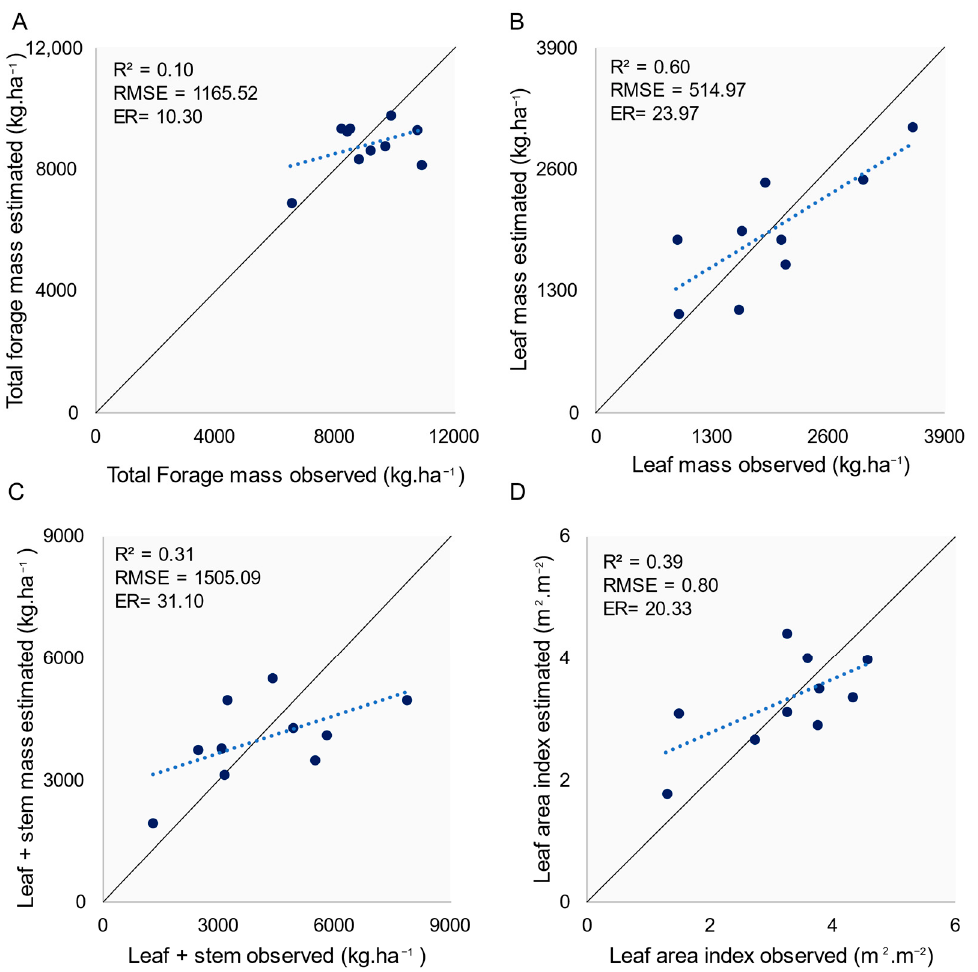
Figure 10. Observed and estimated variables linear regression of Piatã grass pasture in the INT. ( A ) total dry mass (MSt); ( B ) dry mass of leaves (MSf); ( C ) leaf and stem dry mass (MSfc); ( D ) leaf area index (LAI).